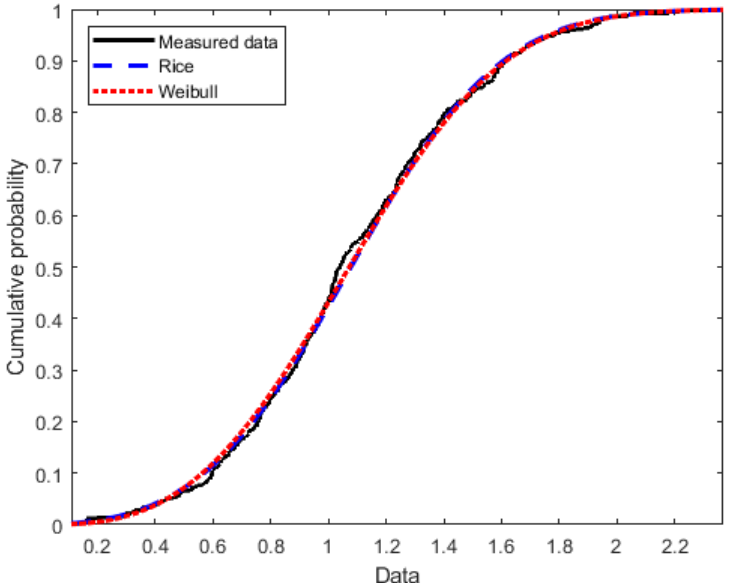
Figure 14. Cumulative distribution functions fitting fast variations within the large lab at 5.8 GHz in LoS conditions.